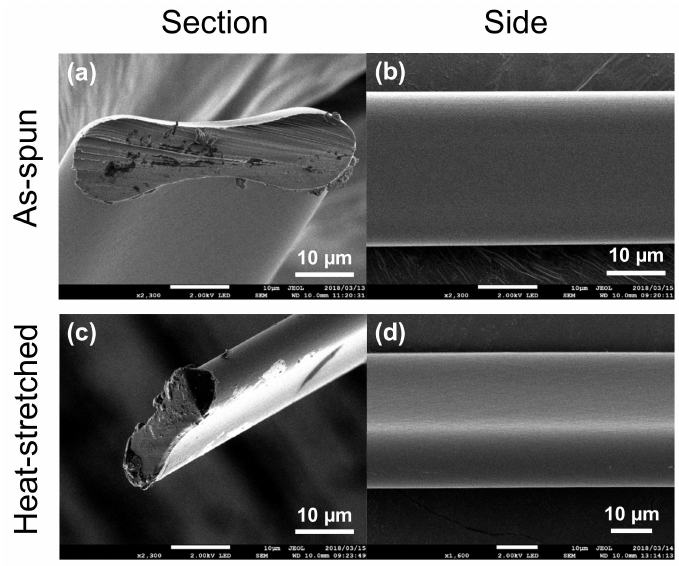
Figure 2. SEM images of regenerated silk fibroin (RSF) fibers: ( a ) sectional and ( b ) side images of RSF as-spun fibers; ( c ) sectional and ( d ) side images of RSF heat-stretched fibers. Each picture has a 10 µ m scale bar. The cross-sections were made by direct immersion to liquid nitrogen and cutting with a razor